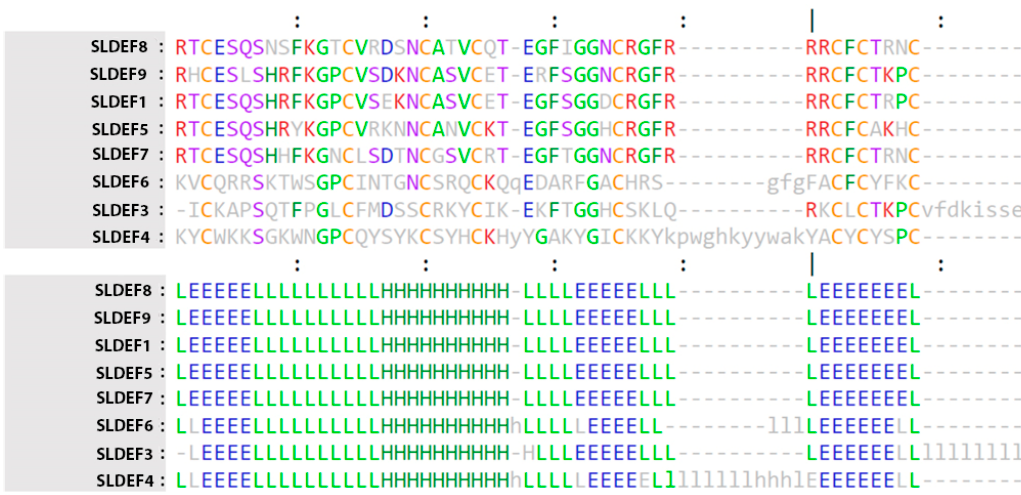
Figure 2. Each accession is shown in the pairwise Dali-alignment. Uppercase means structurally equivalent positions to SlDEF8. Lowercase indicates insertions relative to SlDEF8. The first part depicts the amino acid sequences of the selected neighbors. The second part shows the secondary structure assignments by DSSP (H / h: helix, E / e: strand, L / l: coil). The most frequent amino acid type is colored in each column. SlDef : Solanum lycopersicum defensin.